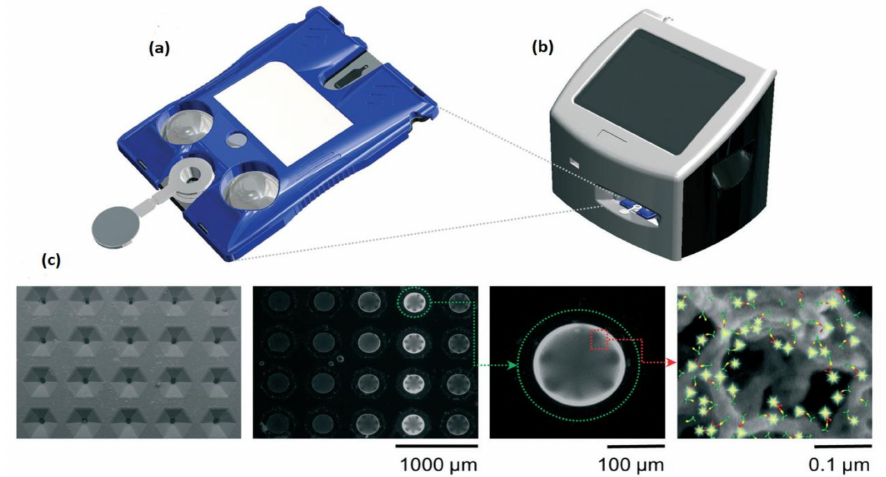
Figure 33. ( a ) The cartridge used in programmable bio nanochip (p-BNC) assay system. ( b ) Portable instrument. ( c ) SEM image, a fluorescent micrograph of bead sensors. Figure adapted with permission from